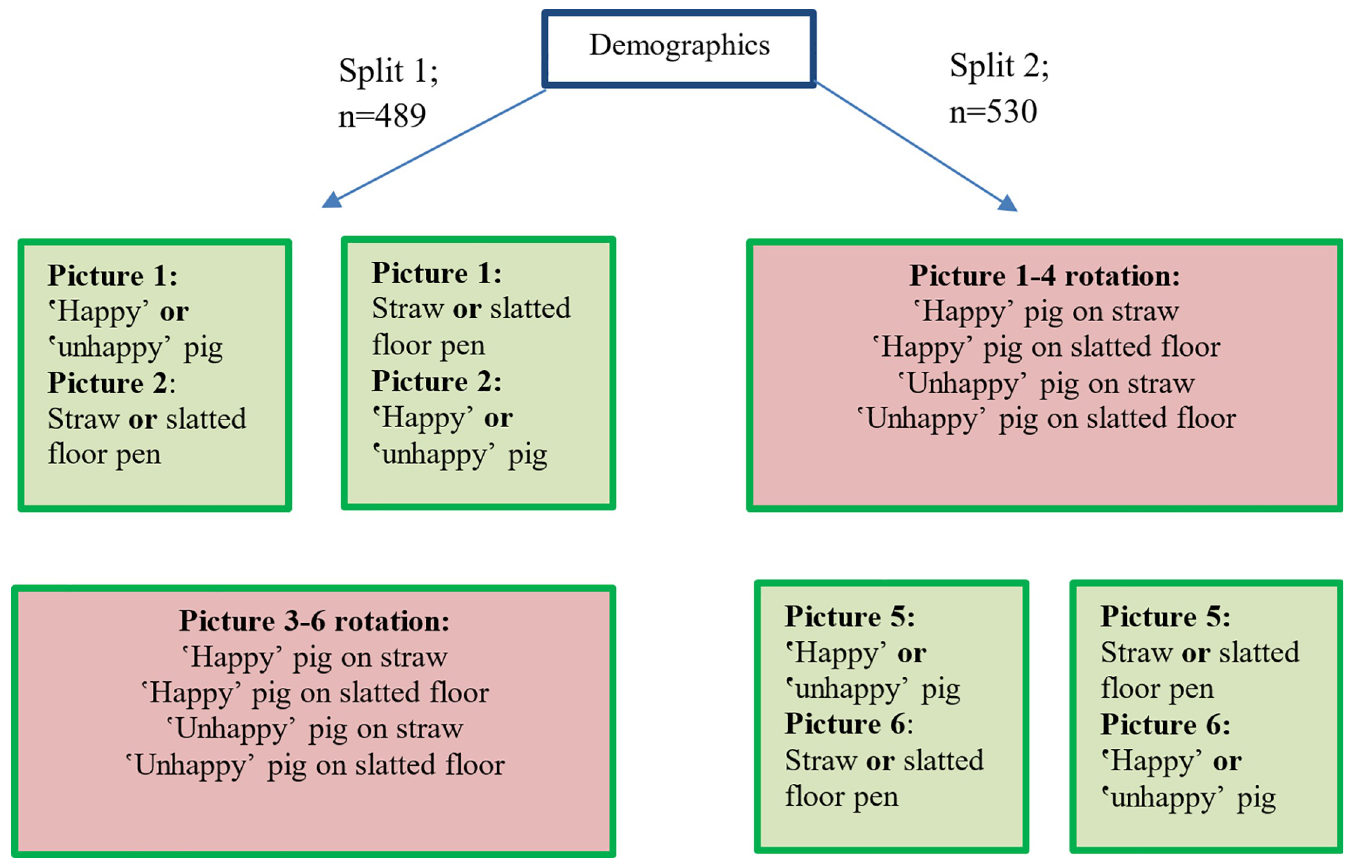
Fig 1. Survey design and sample splits. The order of pictures 1 and 2 (or 5 and 6) as well as pictures 3–6 (or 1–4) was randomized for each sample